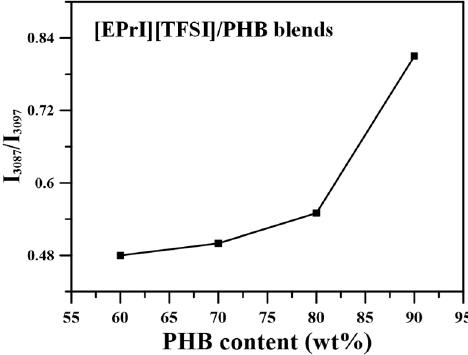
Figure 12. Plot of (I 3087 /I 3097 )-v.s.-PHB content for the [EPrI][TFSI]/PHB blends.